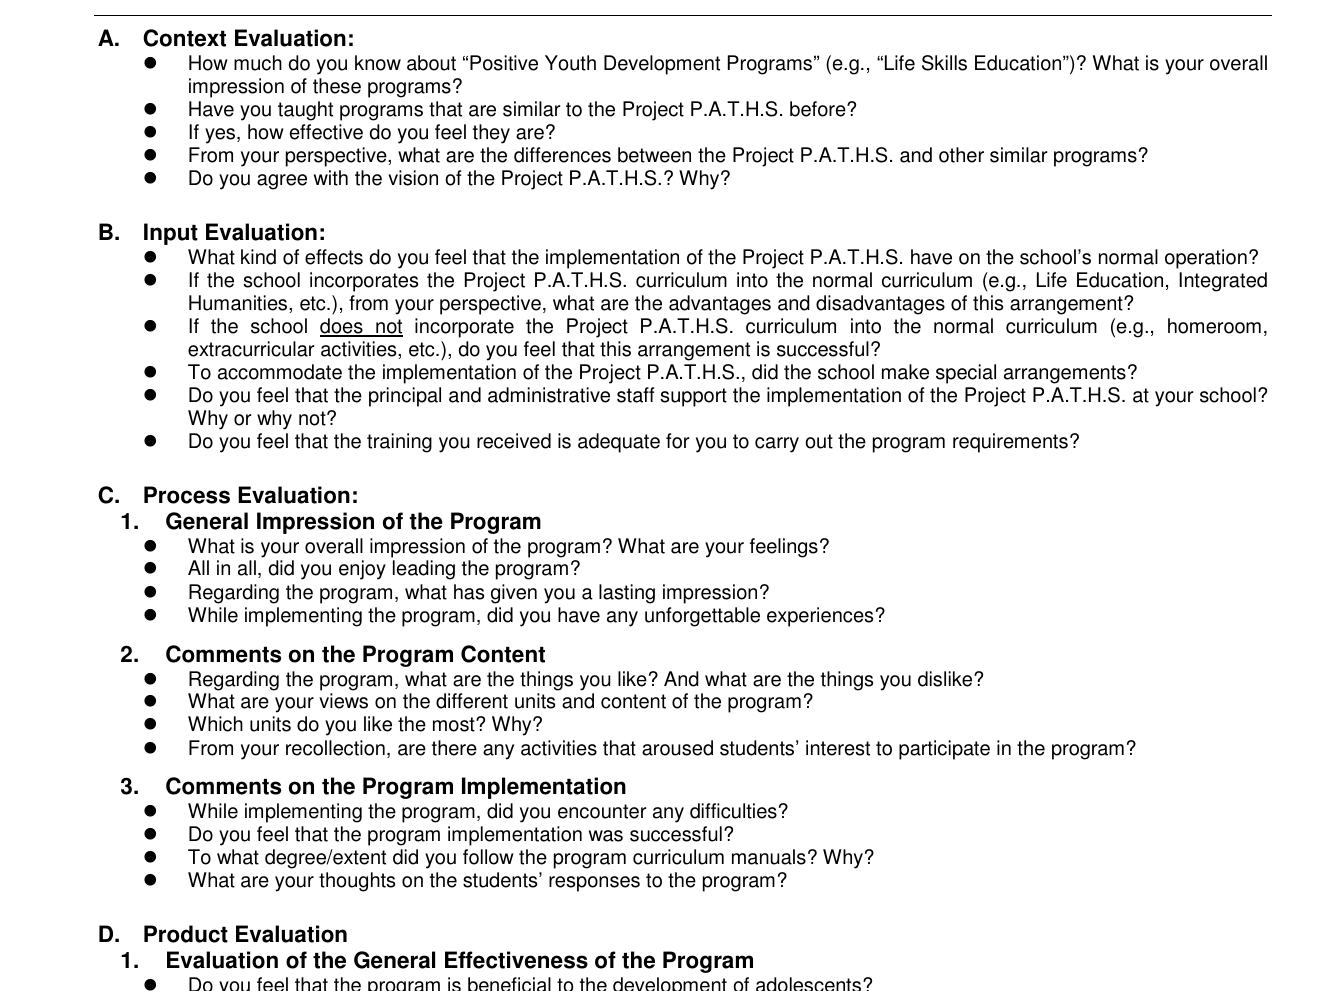
Interview Guide for the Focus Group Interviews Involving the